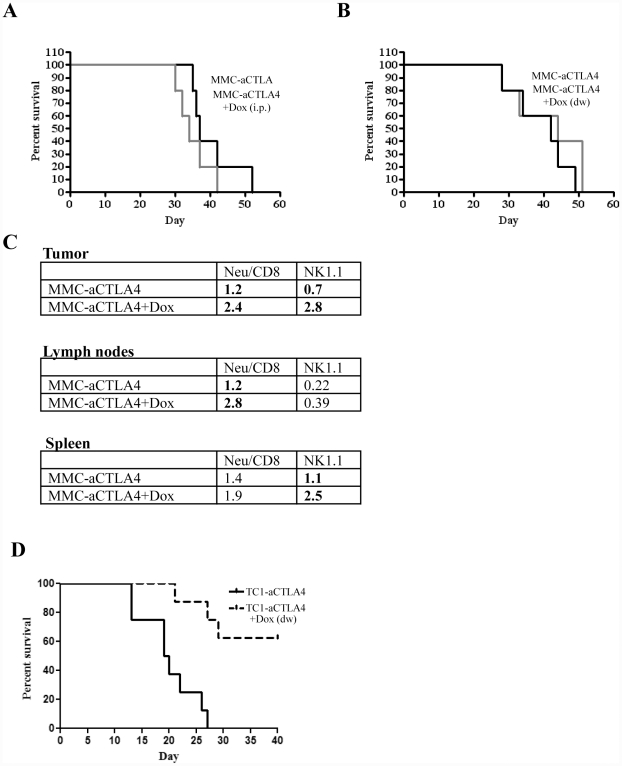
Growth and analysis of tumors derived from tumor cells transduced with LV-aCTLA4.A and B) MMC-aCTLA4 cells were injected and Dox treatment was started when tumors reached a volume of 50 mm3. Kaplan-Meier survival studies (cut-off is 1000 mm3). Dox was delivered with i.p. injection (A) or drinking water (B). N = 5. C) Flow cytometry of tumor infiltrating leukocytes and splenocytes in the MMC-aCTLA4 model. At day 30, tumors, tumor-draining lymph nodes and spleens were harvested. The percentages of Neu specific CD8+ T-cells were measured by tetramer assay. Shown are the average percentages of marked cells in all TILs, lymph node cells and splenocytes. Standard deviations were less than 10%. N = 3. D) TC-aCTLA4 cells were injected and Dox treatment was started when tumors reached a volume of 50 mm3. Kaplan-Meier survival studies (cut-off is 1000 mm3). Dox was delivered with drinking water. N = 5.